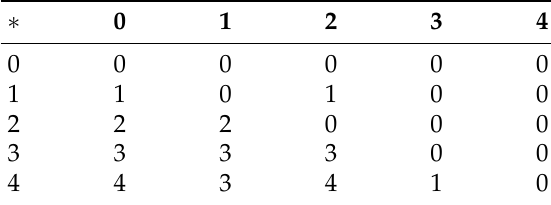
Table 1. Cayley table for the binary operation “ ∗